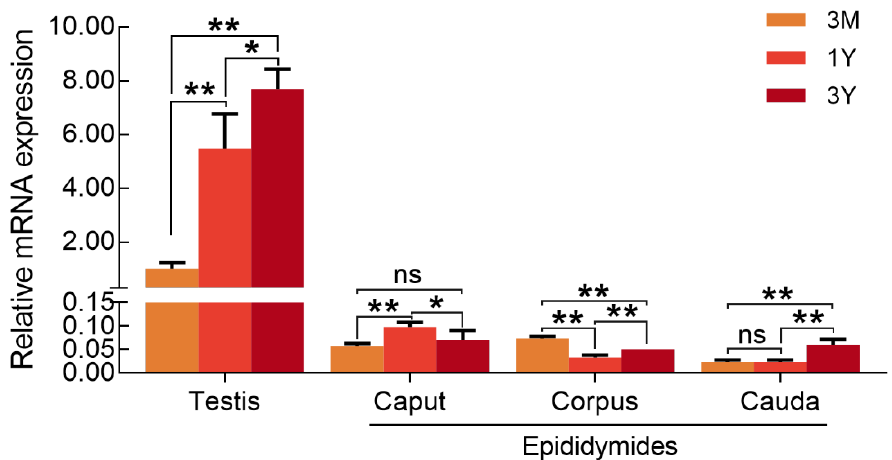
Figure 5. Temporal expression patterns of DMRTC2 mRNA in developmental testes and epididymides. Data show means ± SD from eight independent experiments. **: p < 0.01, *: p < 0.05, and ns (no significance): p > 0.05. 3 M: three months old, 1 Y: one year old, and 3 Y: three years old.